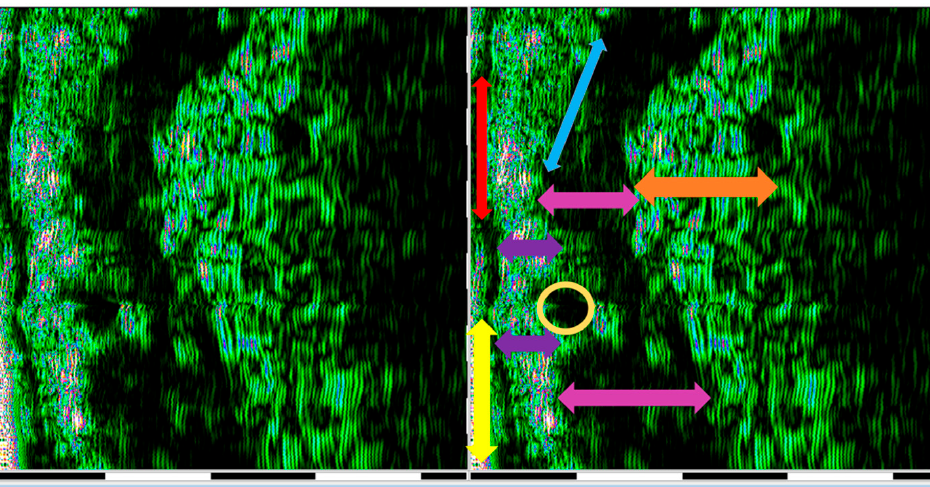
Figure 4. HFU (DUB cutis, Taberna Pro Medicum, Lüneburg, Germany) 22 MHz zygomatic skin evaluation: red arrow—superficial layer of the nonkeratinized epithelium, yellow arrow—spinosum and basal layers of the nonkeratinized epithelium, purple arrow—papillary and reticular layers of the lamina propriae, blue arrow—thin submucosa, pink arrow—orbicular oris muscle, yellow circle—minor salivary gland, orange arrow—conjunctiva–vascular axis .